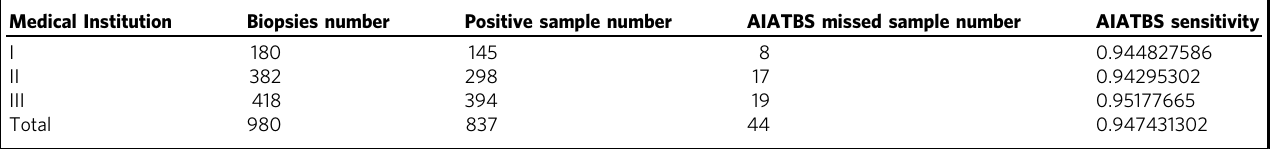
Table 2 The sensitivity of AIATBS system in cervical histological biopsy diagnosis. Medical